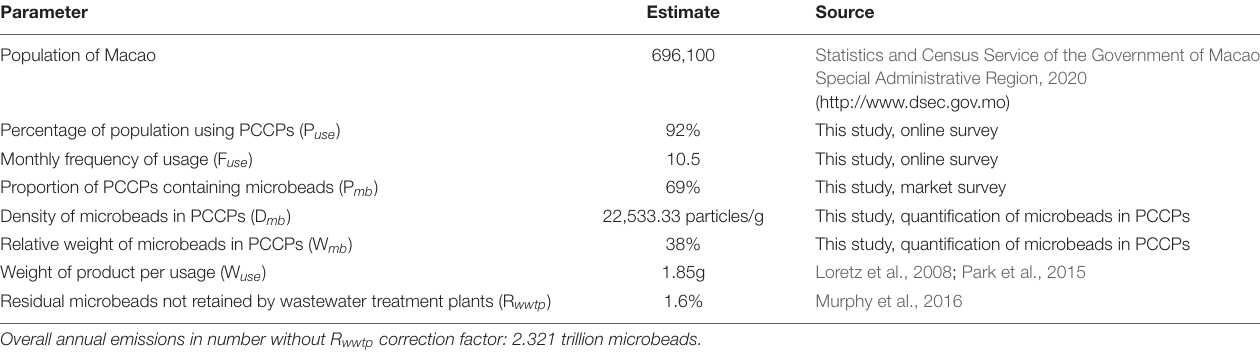
TABLE 3 | Parameters for estimation of total microbeads emission to the environment from the use of personal care and cosmetic products (PCCPs) in Macao. Parameter Estimate